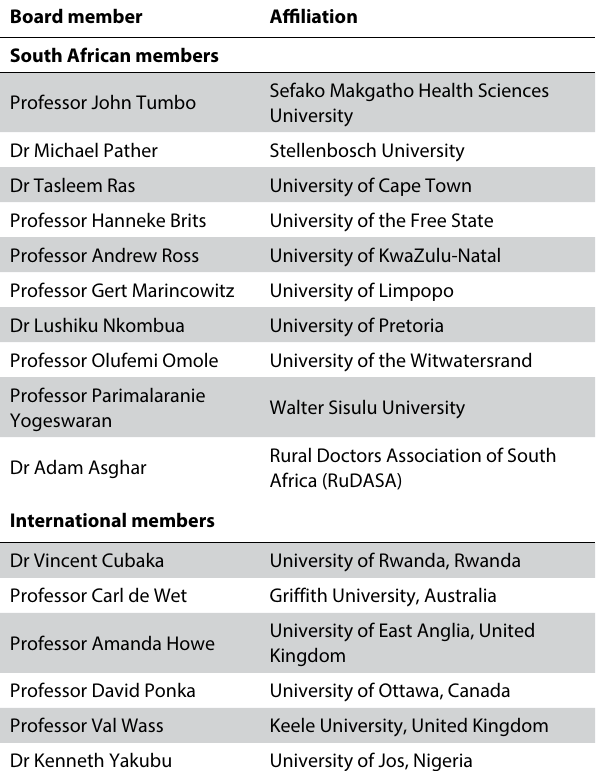
Table 1: The SAFP journal editorial board, 2019 -